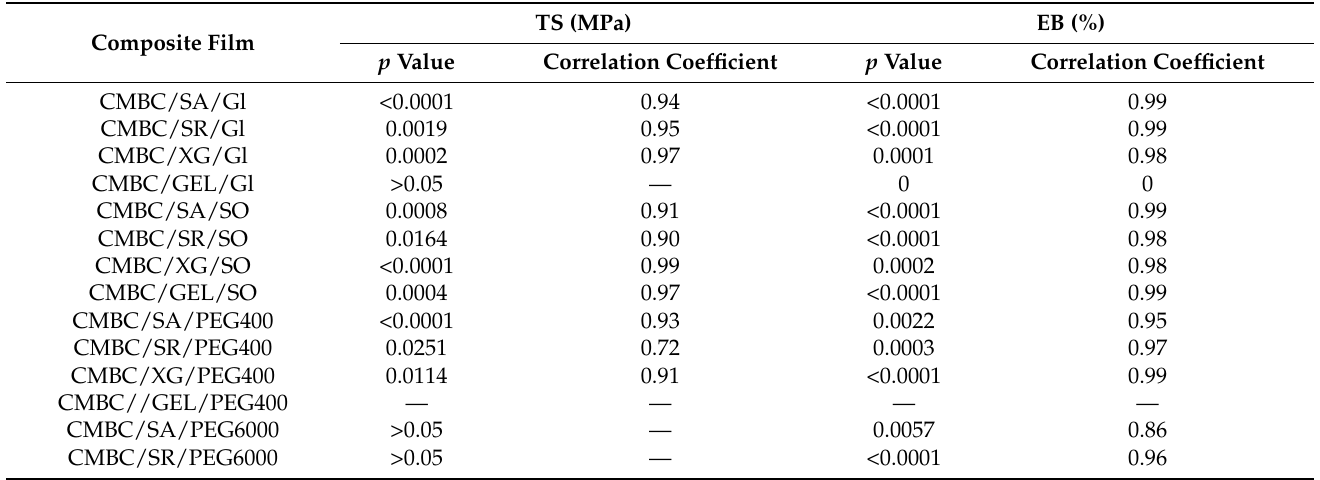
Table 5. p value and Correlation coefficients for the effects of thickeners and plasticizers on tensile strength (TS) and elongation at break (EB) of composite films.